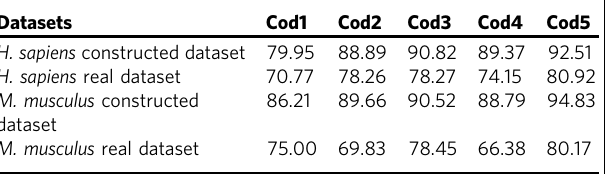
Note: The values in the table are the accuracy (%) of the independent test